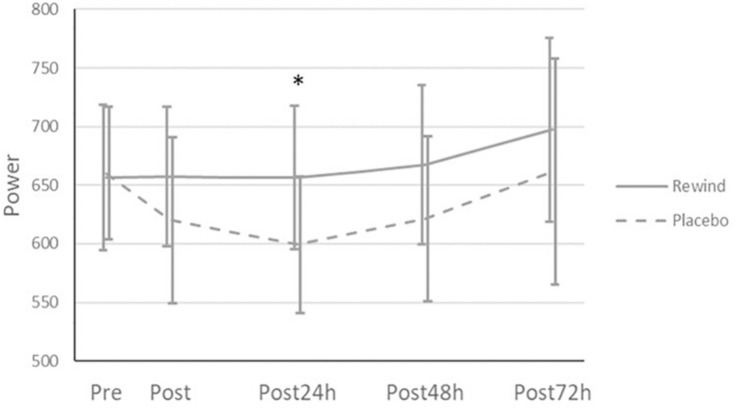
Lower limbs power evolution after exercise comparing ReWin(d) and Placebo groups. *Significant differences (p < 0.05).